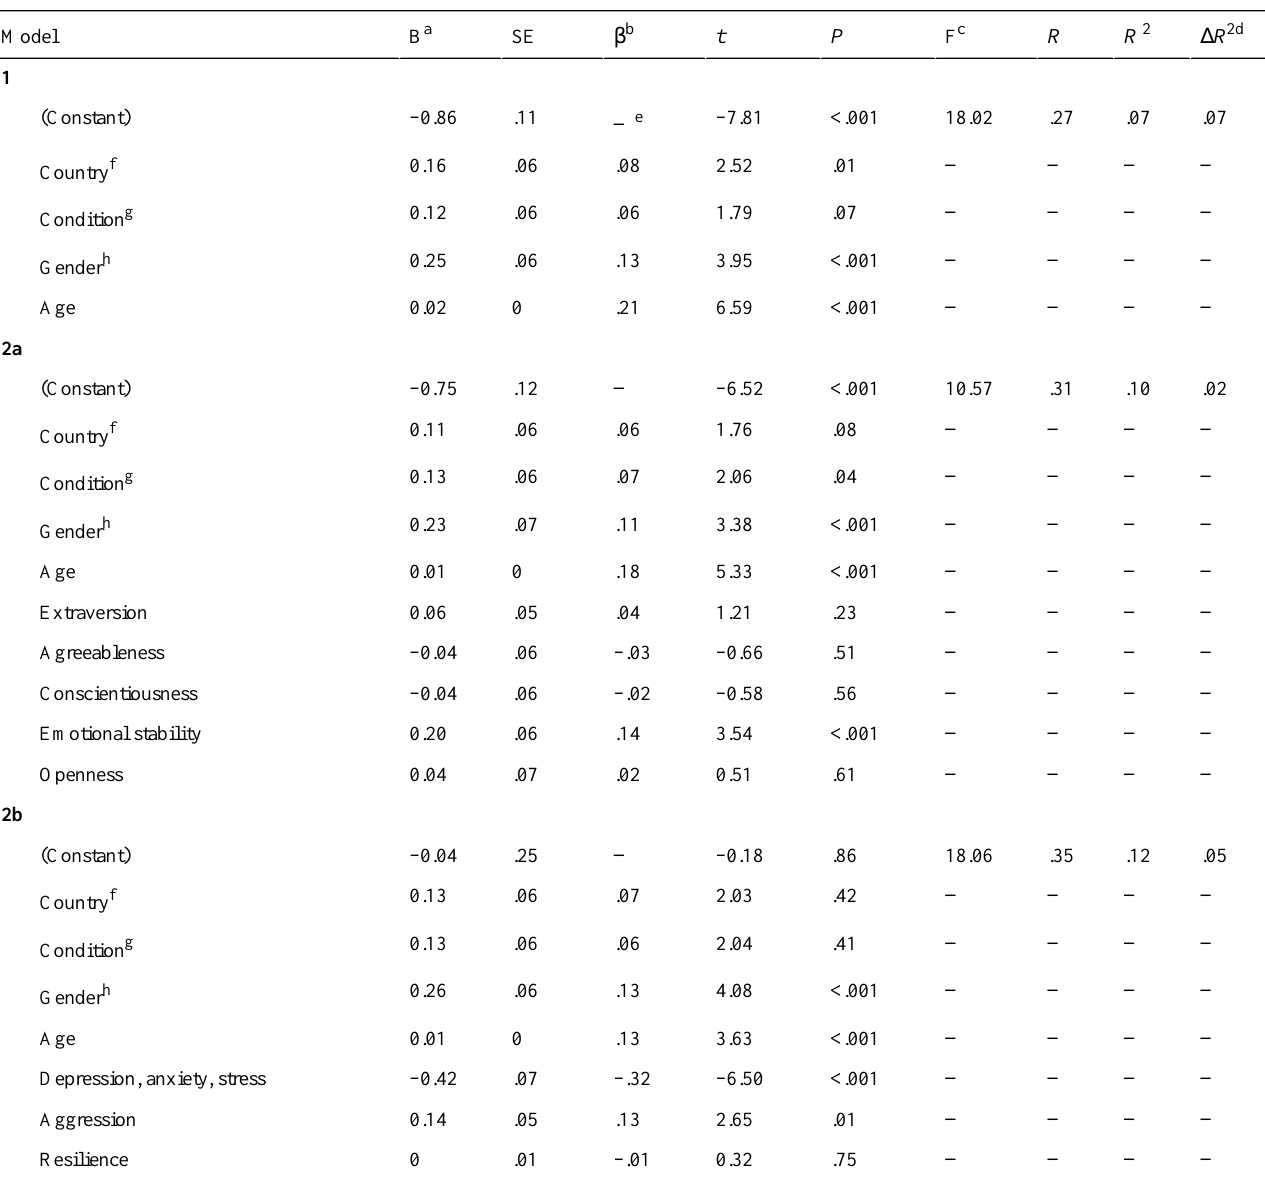
Table 5. Results of hierarchical regression analyses showing amount of variance in the affective versus cognitive/motivational dimension accounted for by country of residence, condition, gender, age, Big Five personality traits, DASS-21, aggression, and